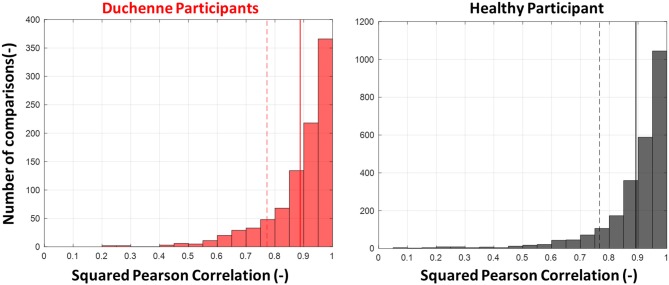
The histogram of squared Pearson correlation between the 10 repetitions for all gestures and for all participants. High correlation shows similarity between the repetitions and thus high repeatability. Both healthy and Duchenne muscular dystrophy (DMD) participants achieved similarly high repeatability on the tasks. The full vertical lines represent the mean and the dashed the standard deviation. The number of unique comparisons between 10 repetitions is 45 multiplied by the seven gestures makes 315 unique comparisons per participant. That explains the total of 2,520 events in the healthy histogram compared to the 945 in the DMD.